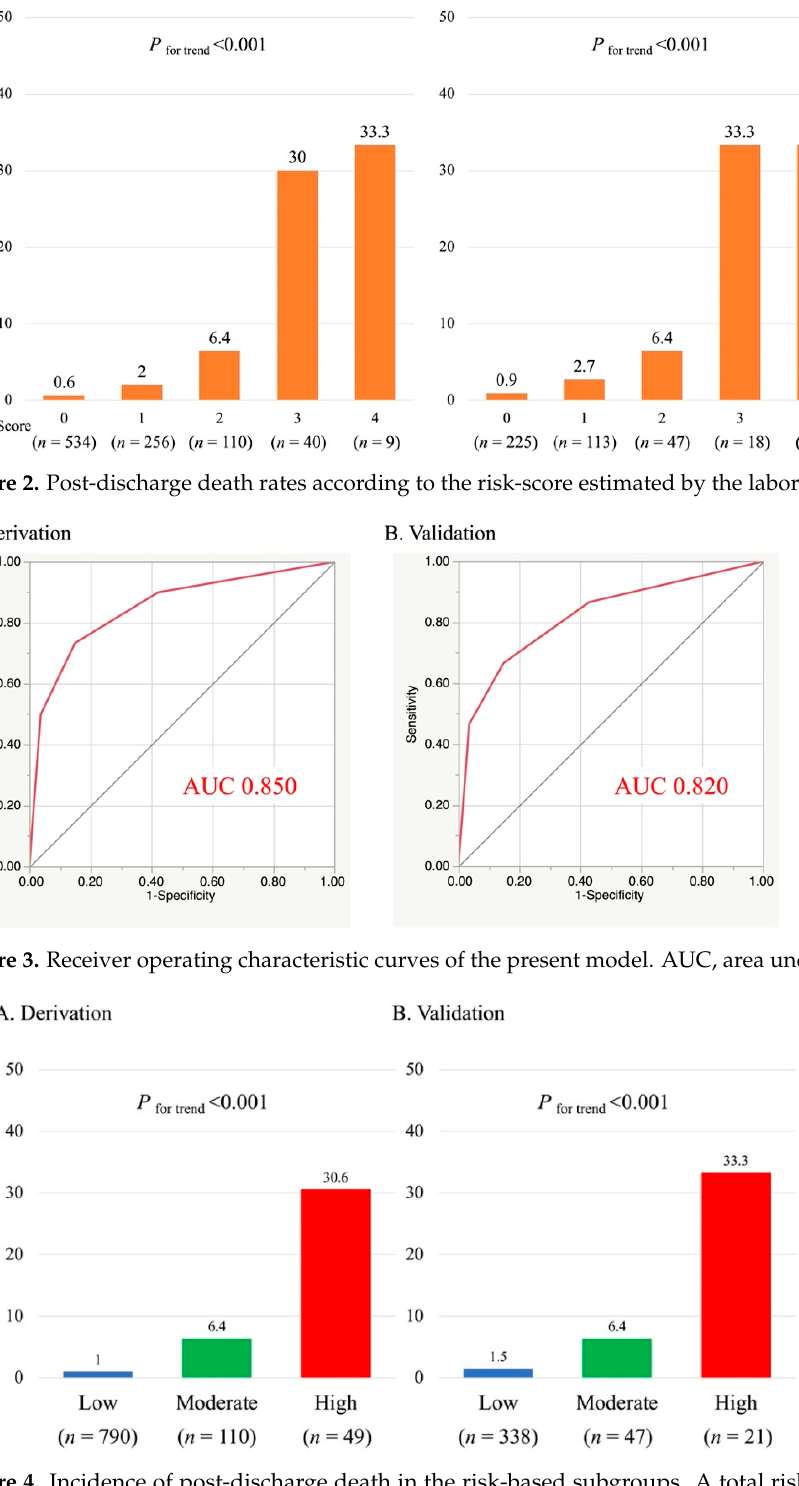
Figure 4. Incidence of post-discharge death in the risk-based subgroups. A total risk score of 0–1 point was defined as low-risk, 2 points as moderate-risk, and 3–4 points as high-risk.